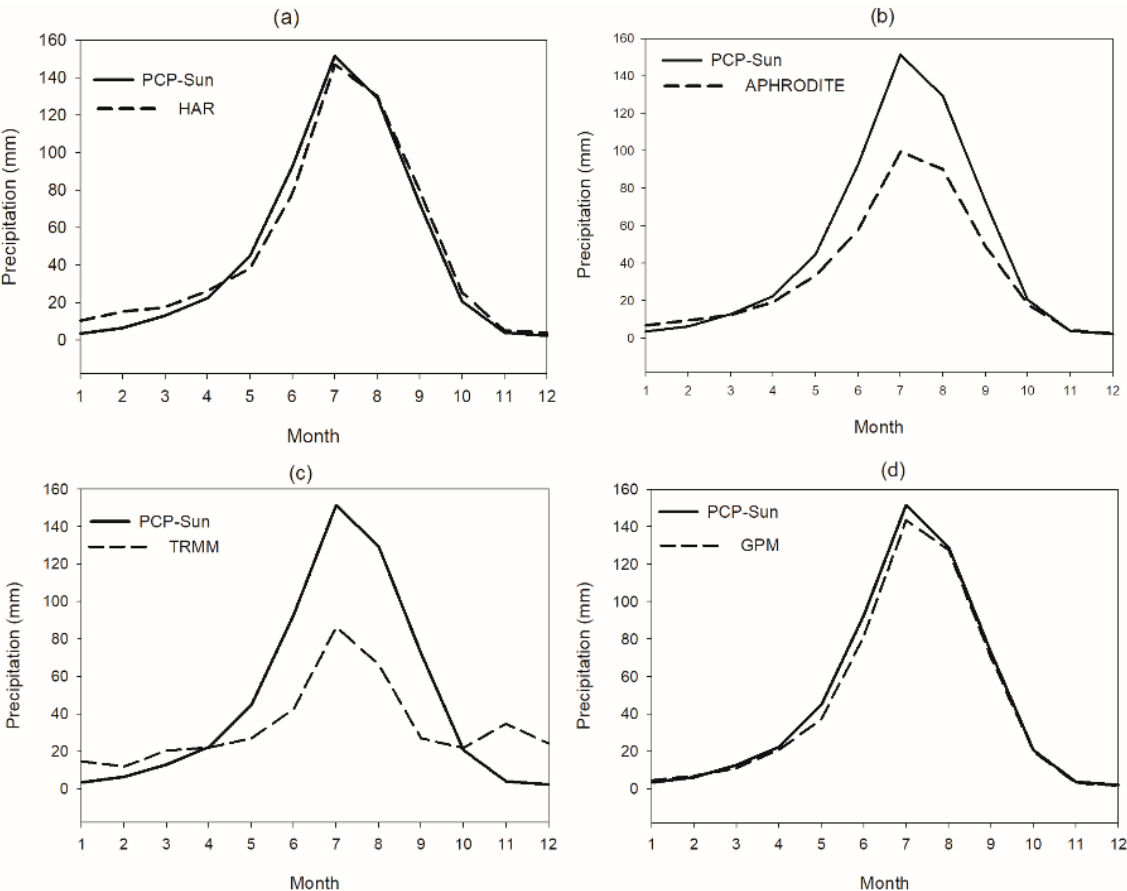
Figure 3. Mean monthly precipitation from four products ( a ) HAR, ( b ) APHRODITE, ( c ) TRMM and ( d ) GPM versus reference precipitation during 2001–2013 over the UB.